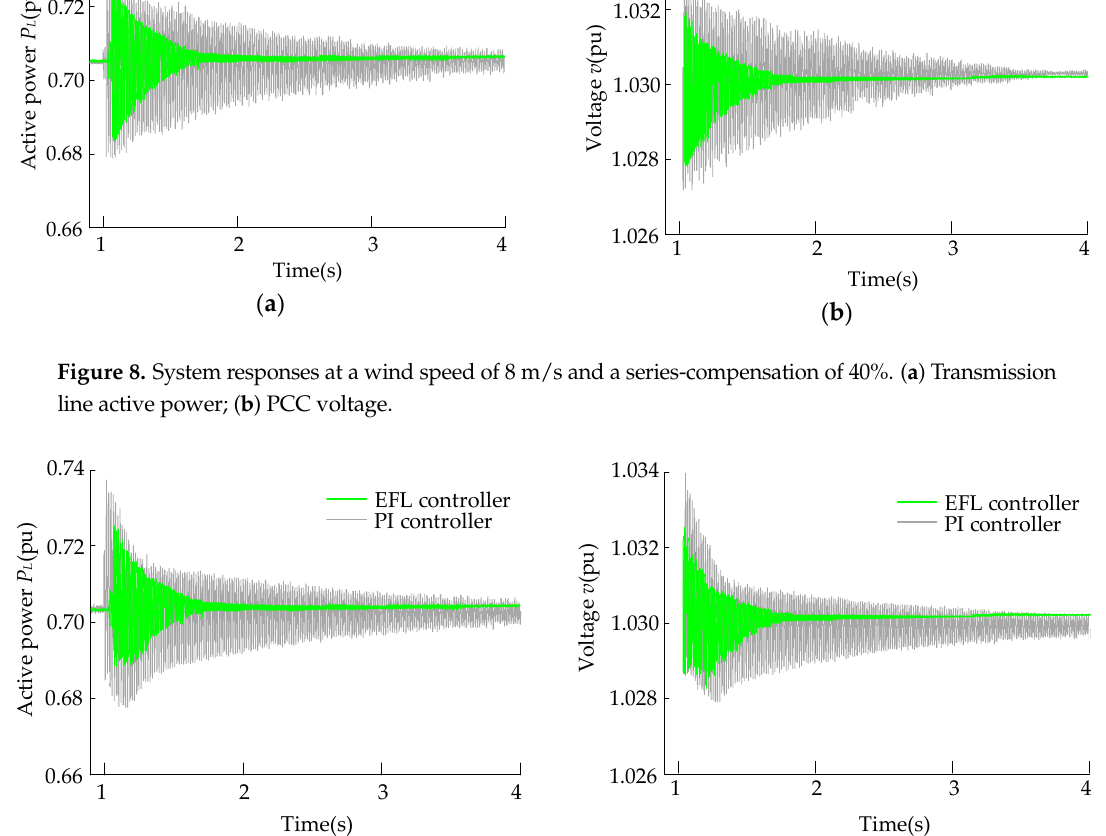
Figure 9. System responses at a wind speed of 10 m/s and for a series-compensation of 70%. ( a ) Transmission line active power; ( b ) PCC voltage.